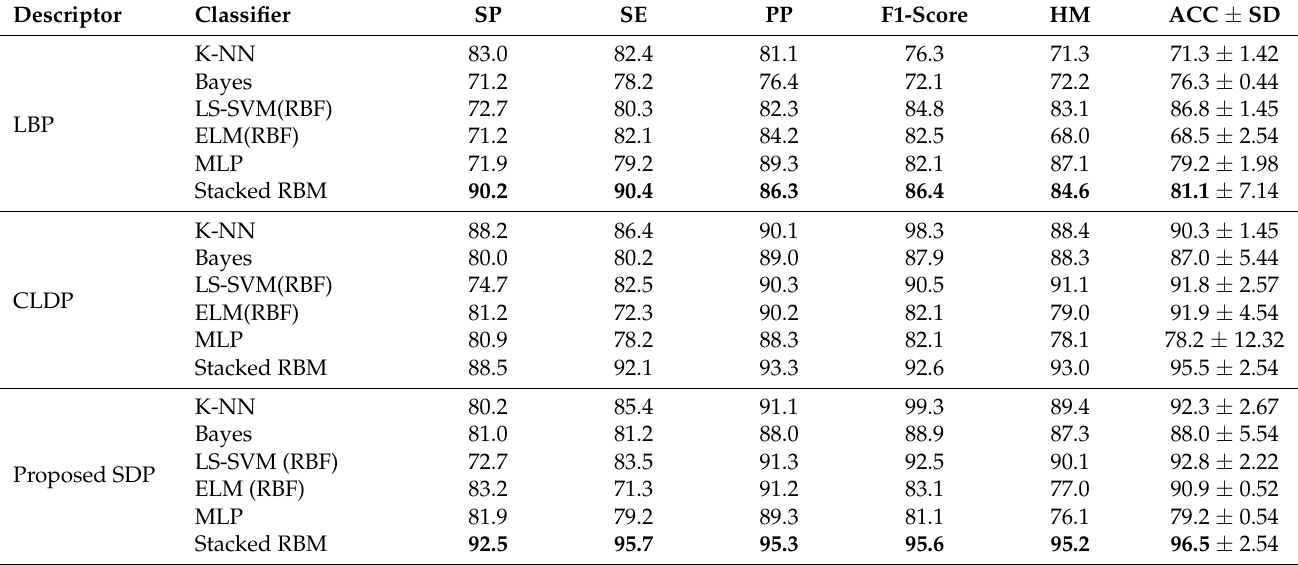
Table 5. Classification outcomes for the pictures of ISIC 2016.